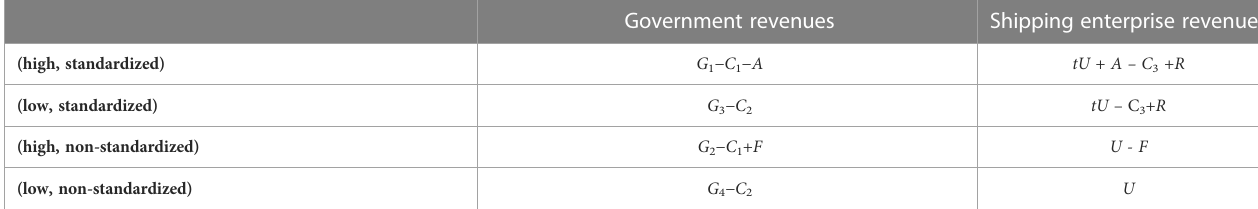
TABLE 2 Revenue matrix of the fi rst stage.